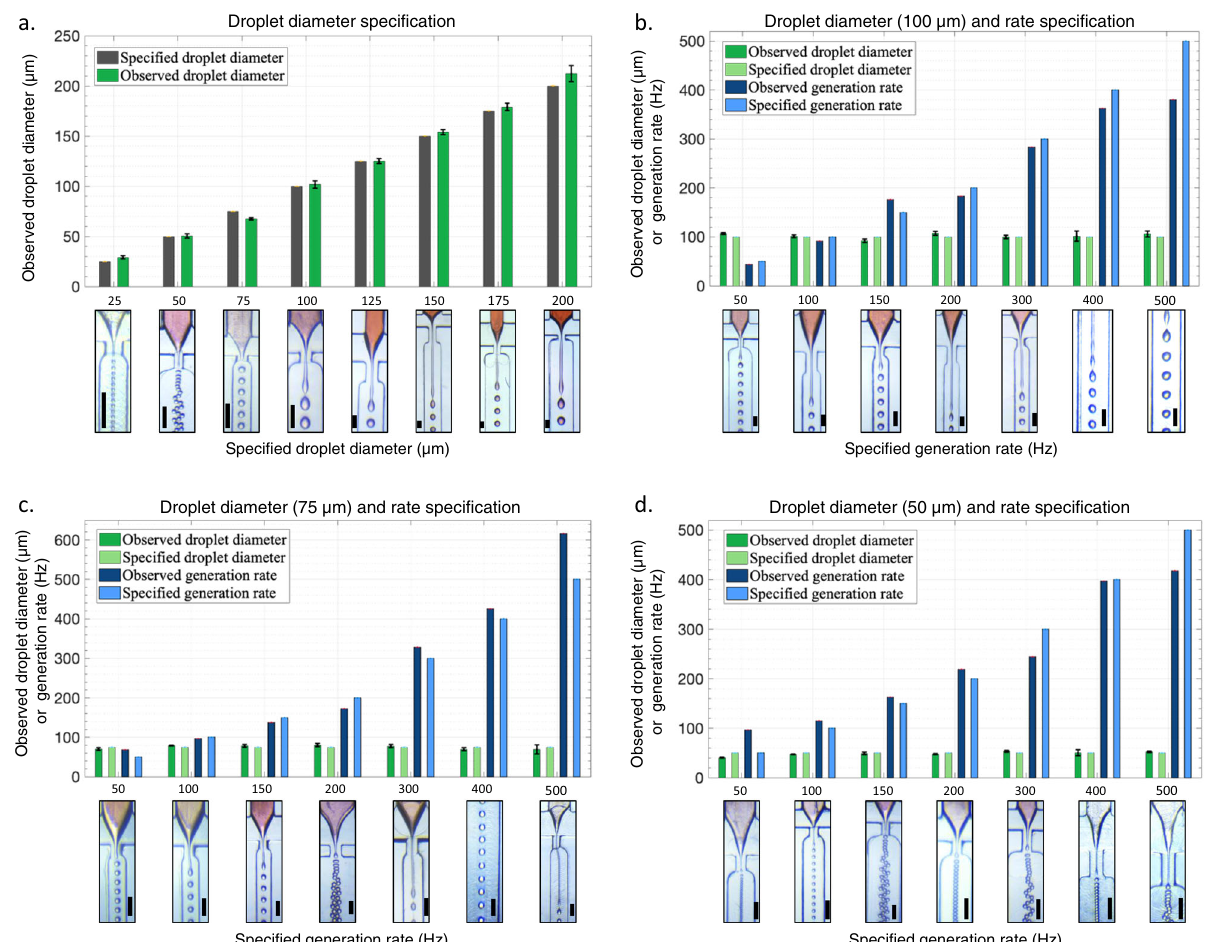
Fig. 6 Machine learning based design automation of micro fl uidic fl ow-focusing droplet generators. a While specifying only droplet diameter, an MAE (MAPE) of 4.2 μ m (5.0%) between the speci fi ed and observed diameters was observed. b When specifying both a droplet diameter of 100 μ m and generation rates ranging from 50 to 500 Hz, an MAE (MAPE) of 4.44 μ m (4.4%) and 33 Hz (12.2%) were observed. c For specifying both a diameter of 75 μ m and generation rate, an MAE (MAPE) of 4.36 μ m (5.8%) for droplet diameter and 33 Hz (14.4%) for generation rate were observed. d For specifying generation rate and a droplet diameter of 50 μ m an MAE (MAPE) of 3.92 μ m (7.8%) and 41.3 Hz (38.8%) were observed. The scale bars represent 200 μ m. Error bars represent two standard deviations and are calculated by analyzing the variations in droplet diameter (droplet polydispersity) for each